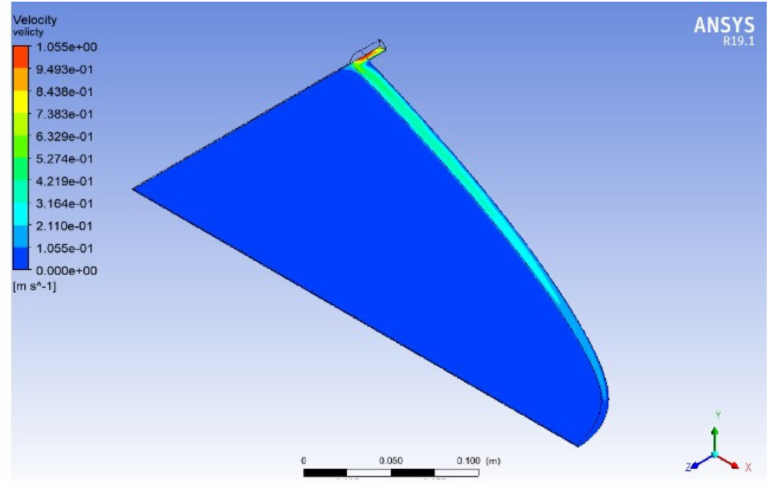
Figure 7. Velocity distribution of an optimized coat-hanger die using the proposed model for a power-law fluid with a circular manifold (power-law index n = 0.38, flow rate Q 0 = 5 × 10 − 5 m 3 /s, die width b = 360 mm and land height h s = 1.5